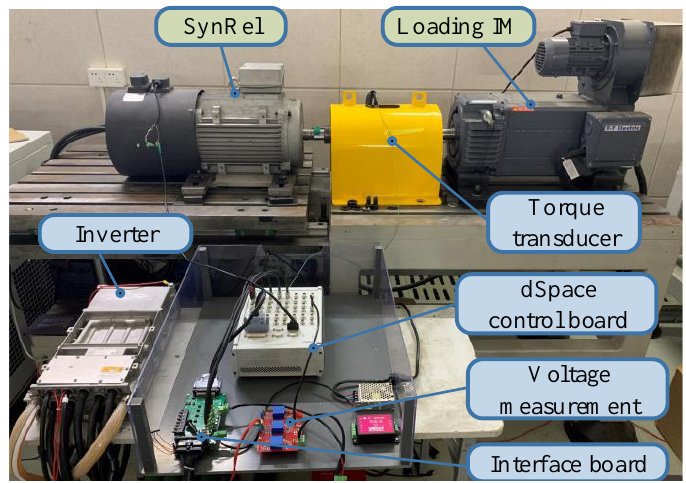
Figure 23. Test rig for co-simulation